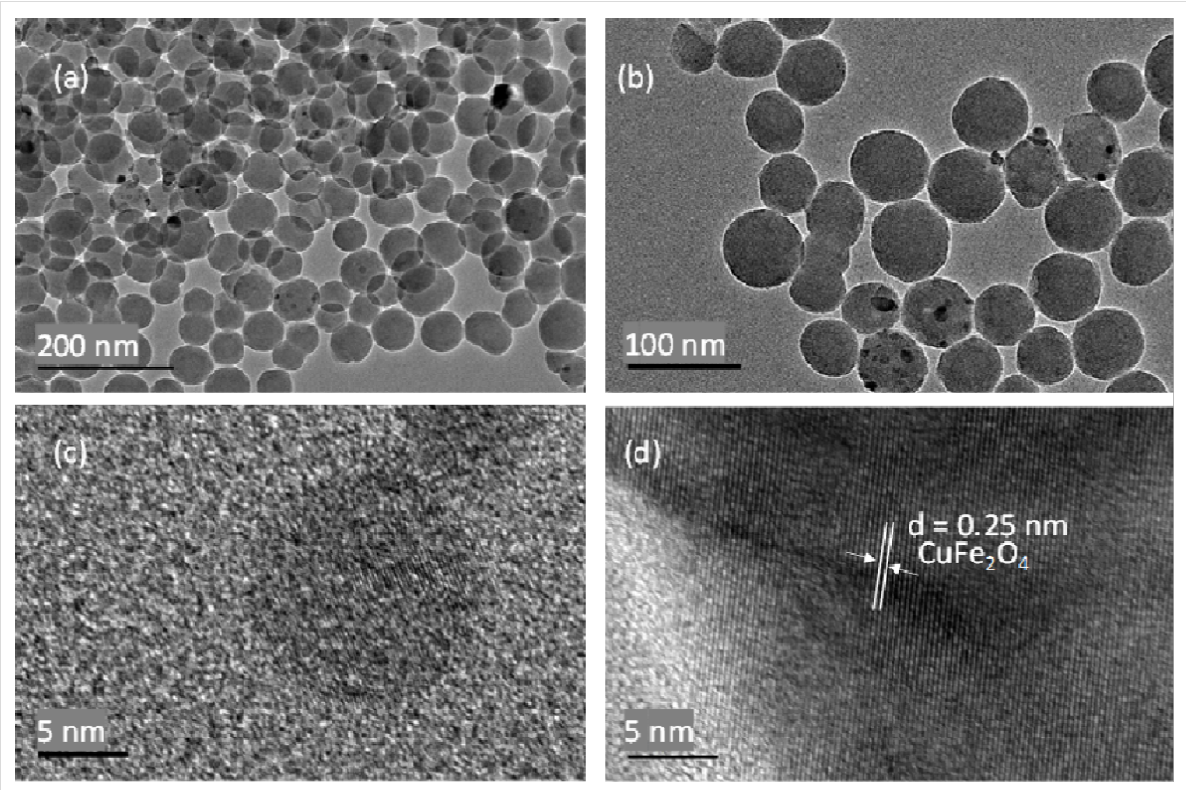
Figure 4: Transmission electron microscopy of (a, b) 30 wt % CuFe 2 O 4 /HYPS at different scale magnifications and (c, d) high-resolution TEM (HRTEM) images of CuFe 2 O 4 /HYPS.